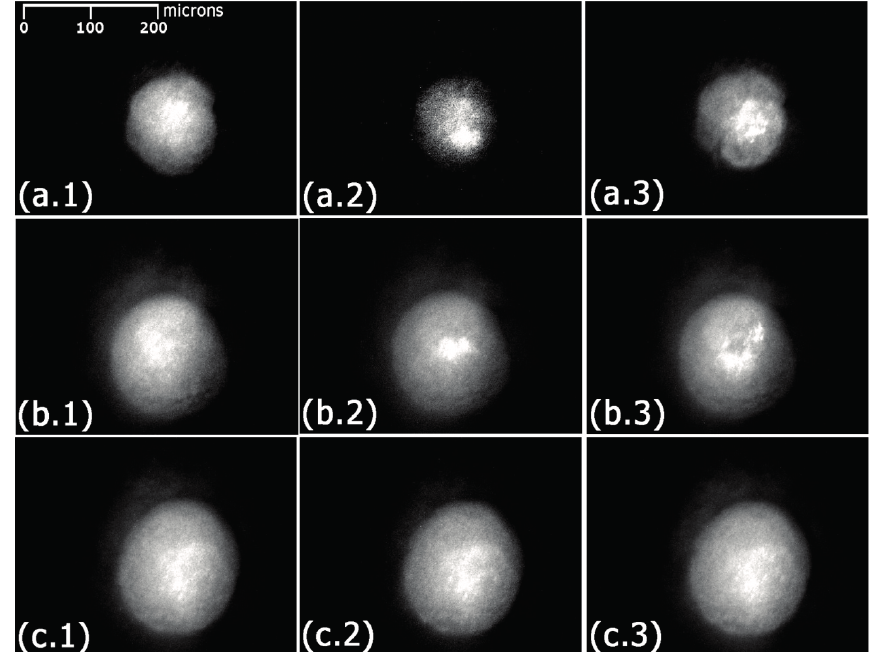
Figure 2. Strobe images of the snow microstructures at different laser fluences and at different times according to laser-snow interaction. ( a.1–3 ) laser at 1 J/cm 2 ; ( b.1–3 ) at 0.45 J/cm 2 and ( c.1–3 ) at 0.35 J/cm 2 ; ( a-c.1 ) strobe image before the interaction; ( a-c.2 ) an image 7 ns after the interaction and ( a-c.3 ) long after the interaction, few